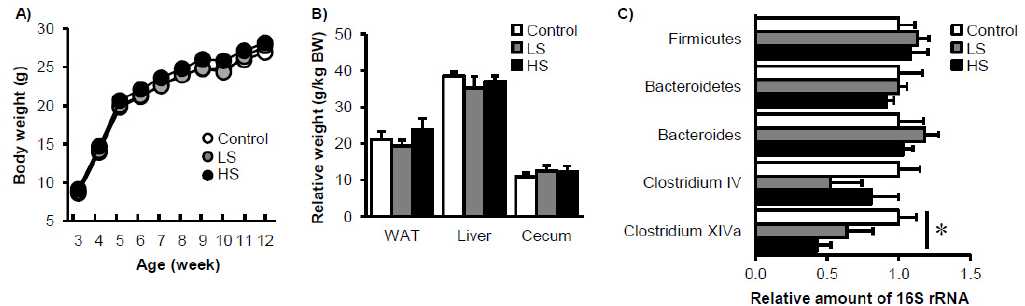
Figure 1. Gradual changes in body composition and gut microbiota in mice fed sucralose. Changes in body weight ( A ), organ weight ( B ), and abundance of specific bacterial phylum and genus ( C ) after 8 weeks of sucralose feeding. Data represent mean ± S.E. ( n = 8). * Concentration-dependent effects were observed by regression analysis, p < 0.05. LS: low sucralose (1.5 mg/kg BW/day), HS: high sucralose (15 mg/kg BW/day).